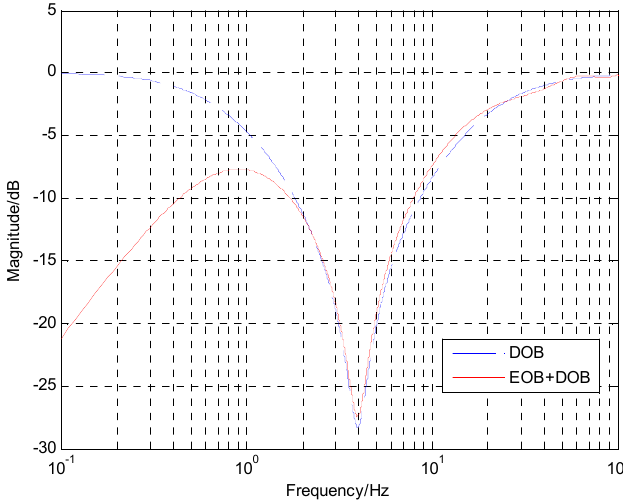
Figure 8. The simulation of the ADA improvement.